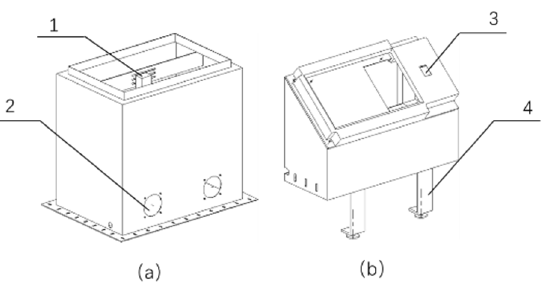
Figure 2. Structural diagram of the Yinghong No. 9 tea leaves moisture content detection system: ( a ) dark room; ( b ) control room; (1) Camera; (2) Fan; (3) fingerprint recognition module; (4) buckle.